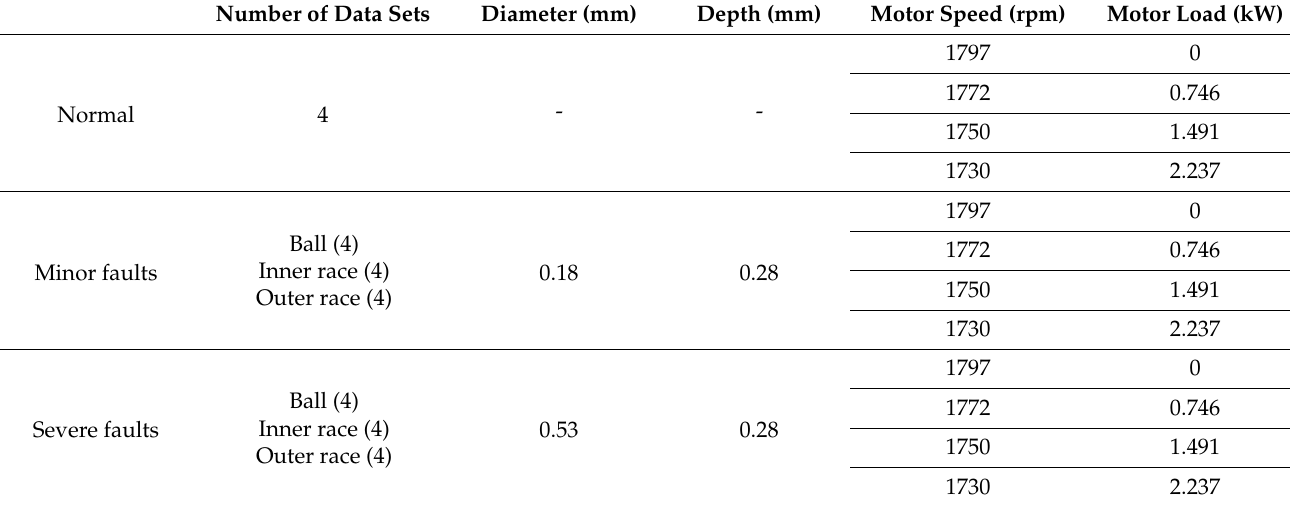
Table 2. Specifications of the different bearing